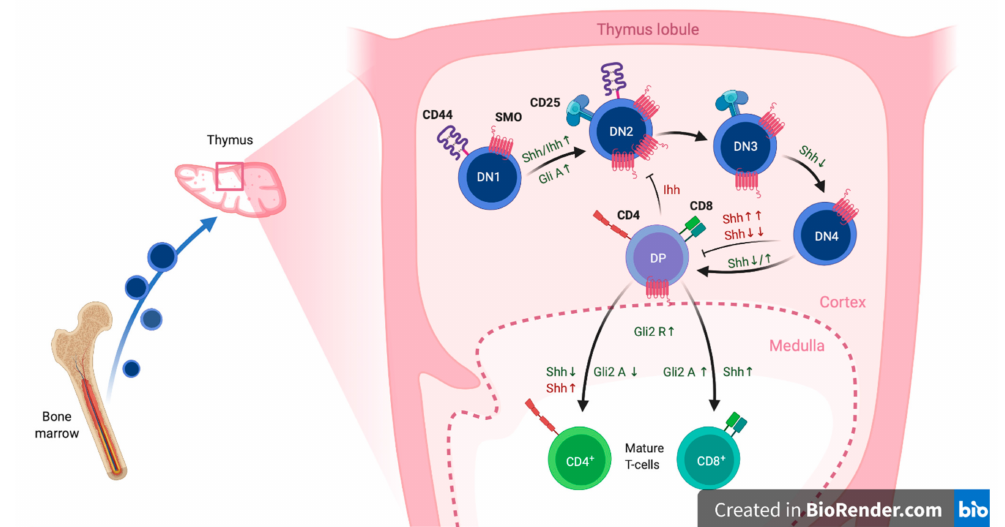
Figure 3. Summary of the differential expression and signalling effects of SMO, including its upstream signals (Hh) and its downstream transcription factors (Gli) on T-cell development in the thymus. Inhibitory signals and effects are highlighted in red, differentiation stimulating effects are marked green. This figure was adapted from “T-Cell Development in Thymus 2”, by BioRender.com (2021), retrieved from